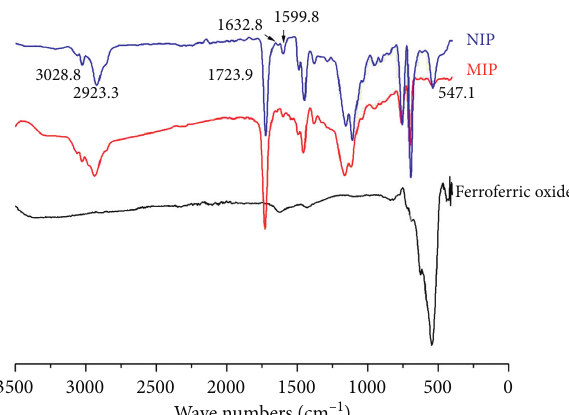
Figure 4: FT-IR spectra of MMIP (red), MNIP (blue), and Fe